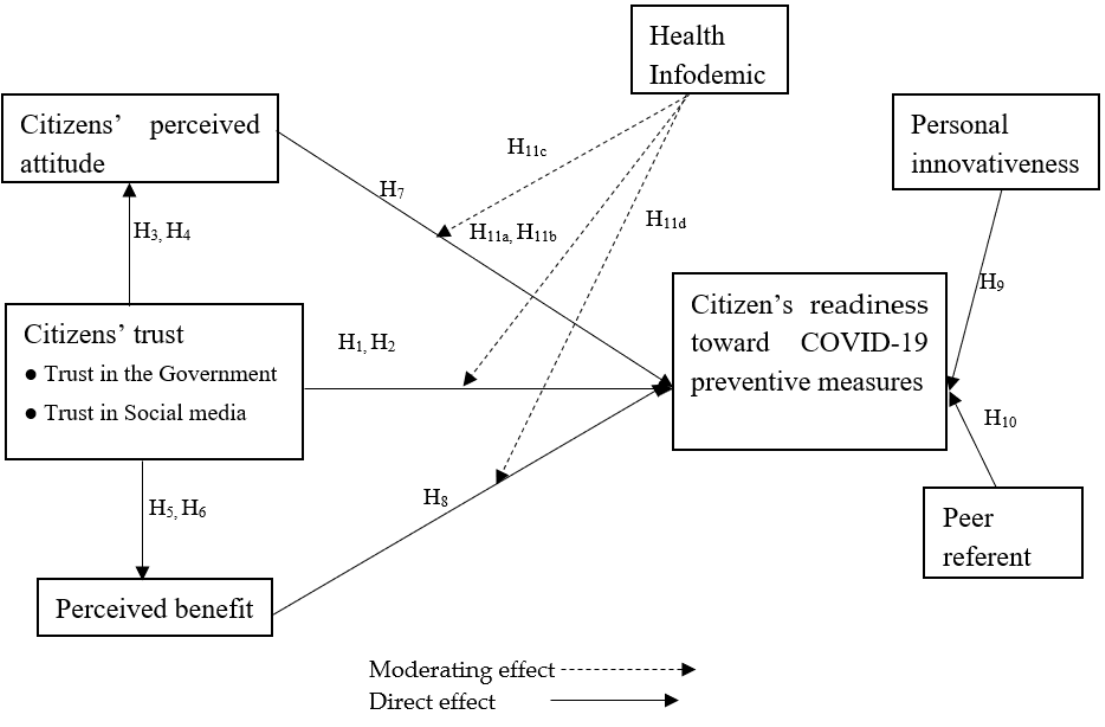
Figure 1. Research